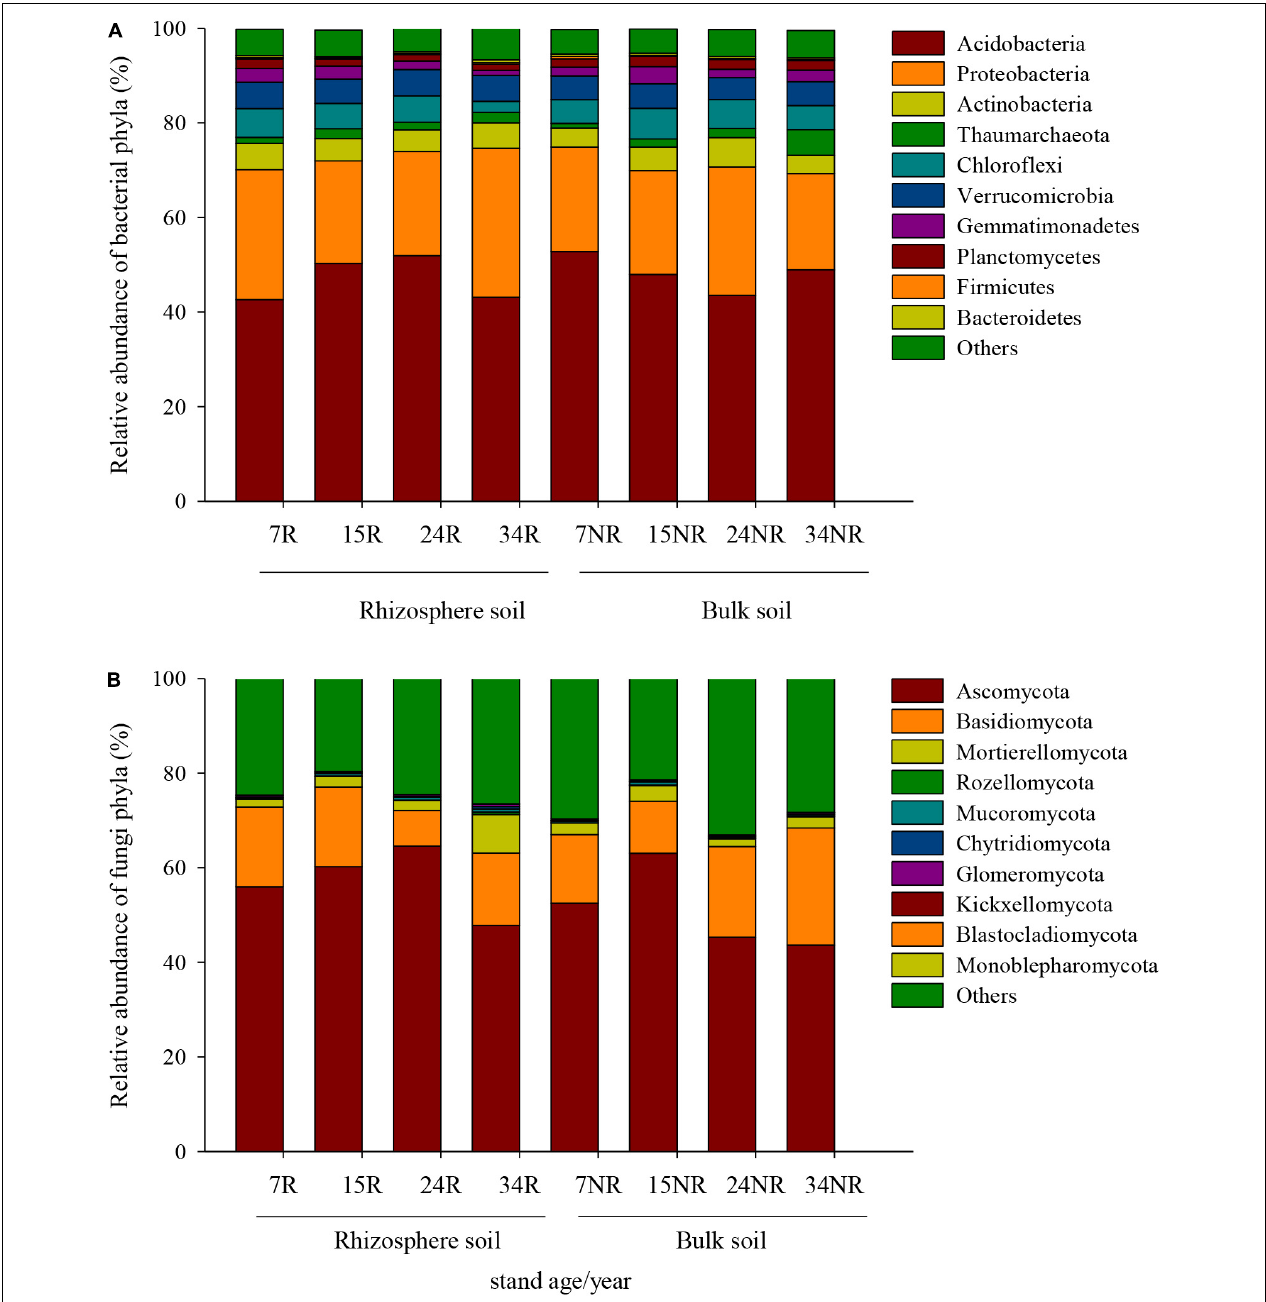
FIGURE 2 | Relative abundance (%) of the most dominant bacterial (A) and fungal (B) groups at the phyla level among different stand ages in Xinkou Forest Farm, Southeastern China. Others represent unclassified